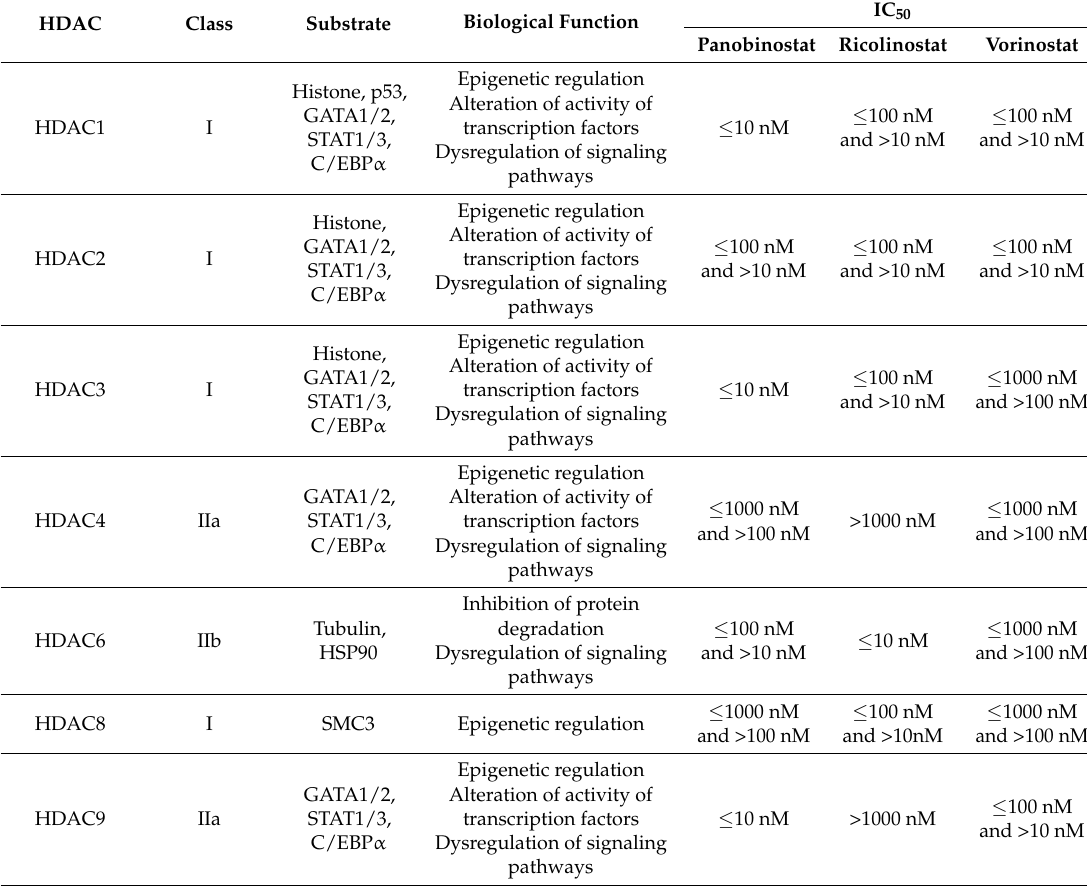
Table 1. The characteristics of each HDAC Classes, substrates, biological functions and IC 50 values for panobinostat, ricolinostat, and vorinostat with respect to each HDAC (HDAC1, 2, 3, 4, 6, 8, 9) are displayed. IC 50 values for panobinostat, ricolinostat, and vorinostat was cited from [2–4],